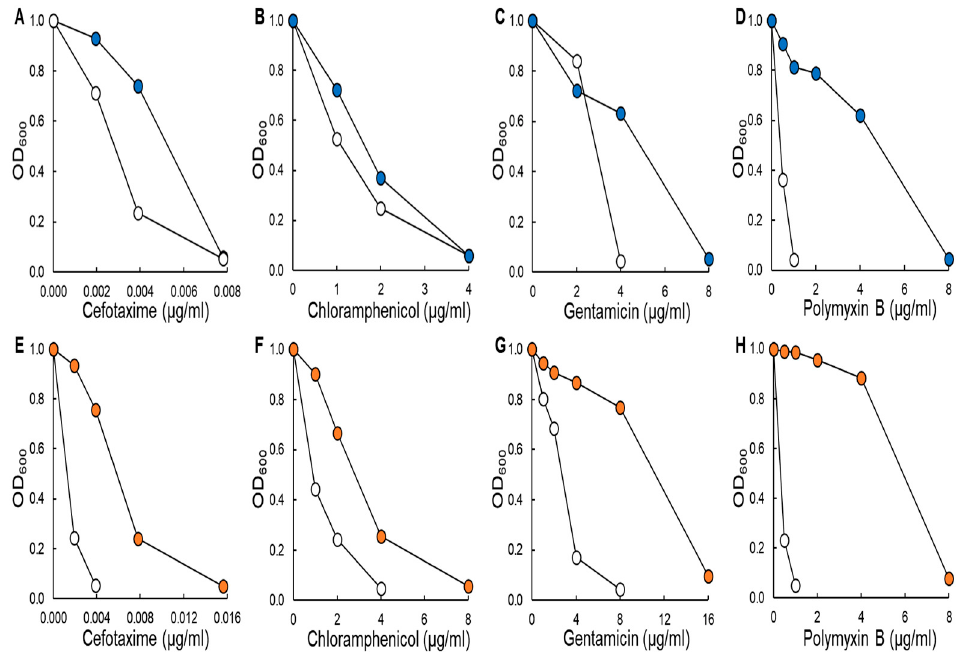
Figure 1. Antibiotic susceptibilities of Salmonella Typhimurium ATCC 19585 (ST ATCC ); ( A – D ) and S . Typhimurium CCARM 8009 (ST CCARM : E – H ) exposed to a half minimum inhibitory concentration (MIC) of cefotaxime (CEF 1/2 ; A , E ), chloramphenicol (CHL 1/2 ; B , F ), gentamicin (GEN 1/2 ; C , G ), and polymyxin B (POL 1/2 ; E , H ) for 0 (control; ○ , ○ ) and 3 ( ● , ● ) days. The optical density (OD) of ST ATCC and the ST CCARM untreated control and after exposure to CEF 1/2 , CHL 1/2 , GEN 1/2 , and POL 1/2 for 3 days was measured after incubating at 37 °C for 18 h.